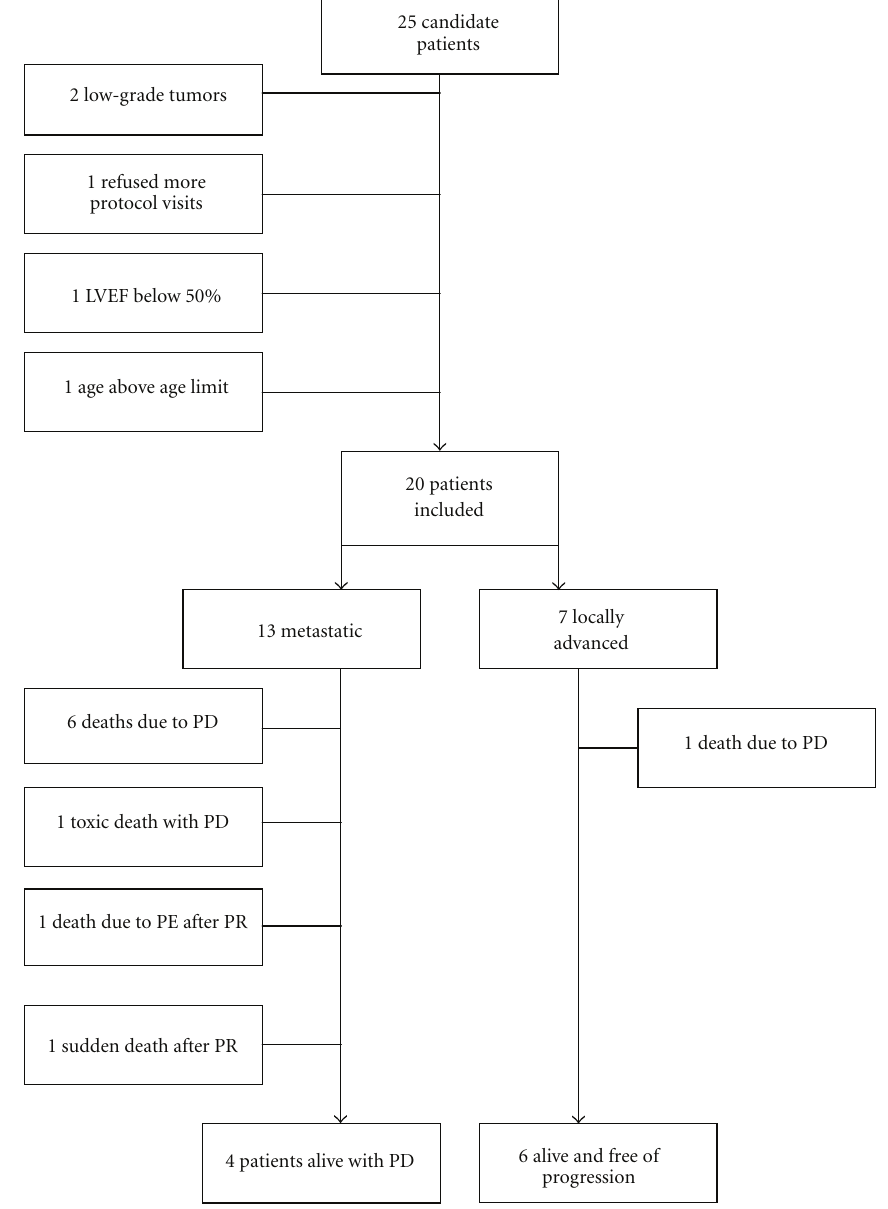
Figure 1: Patient inclusion. LVEF: left ventricular ejection fraction. PE: pulmonary embolism. PR: partial response. PD: progressive